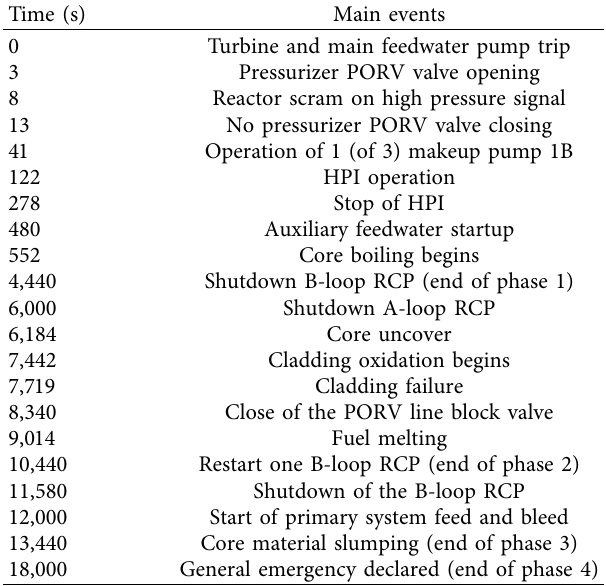
Table 1: Detailed main events in TMI-2 severe accident.